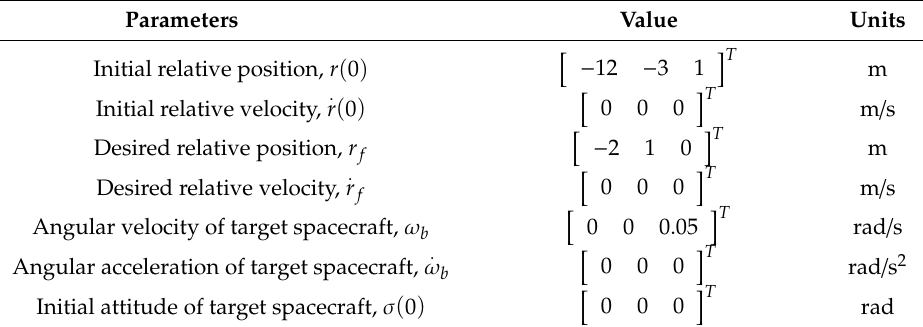
Table 5. Initial relative motion parameters expressed in frame F b .